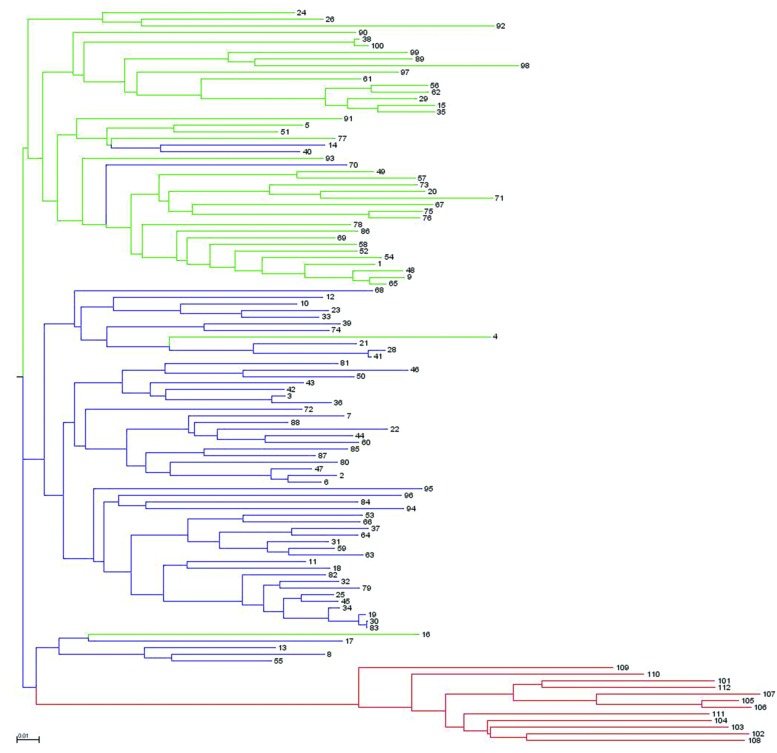
Neighbor-joining dendrogram showing genetic relatedness among the 111 cauliflower accessions of the diversity panel based on 4,758 SNP markers. Accessions are color-coded according to the populations’ substructure assignment to cluster G1, G2, and G3 based on STRUTURE results (see Figure 3).